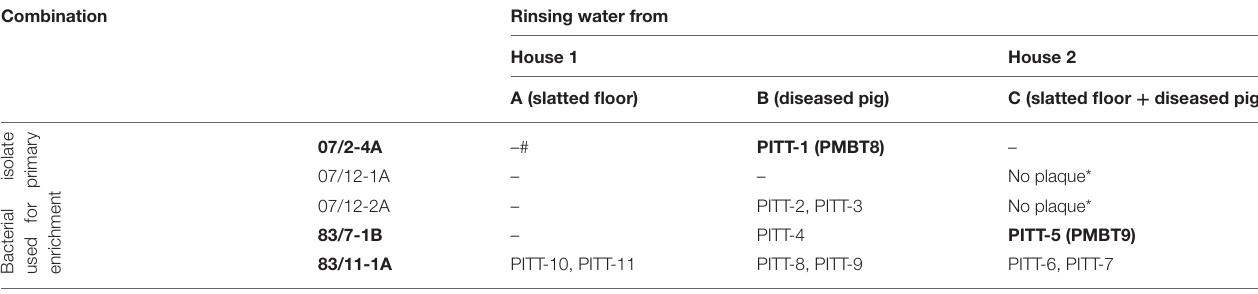
TABLE 1 | Origin of the S. hyicus phages and host strains used for isolation. Combination